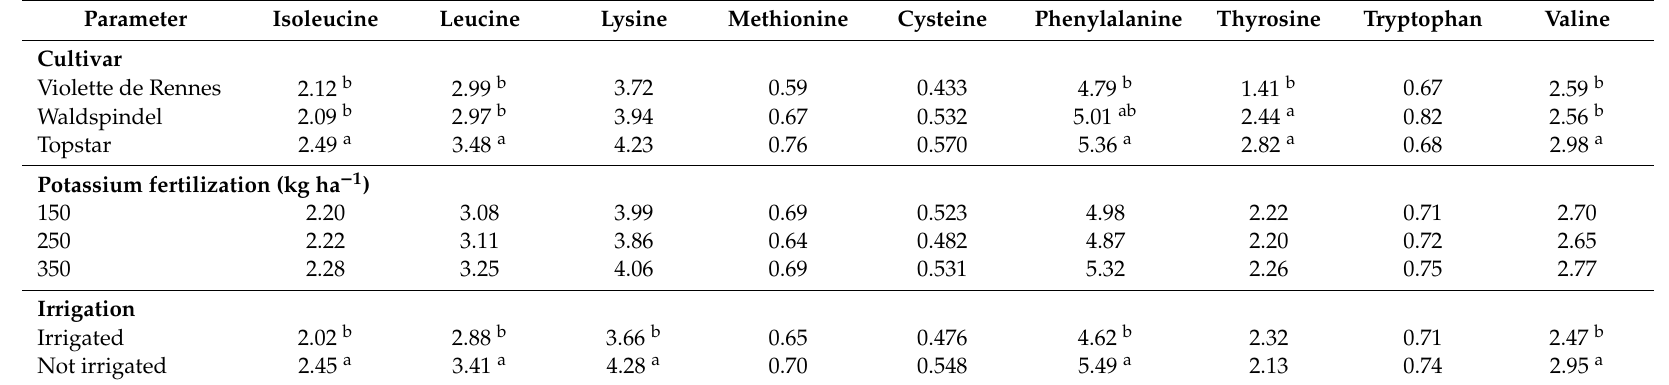
Table 4. The e ff ect of experimental factors on the content of essential amino acids (g 100 g − 1 of protein) in Jerusalem artichoke tubers. Parameter Isoleucine